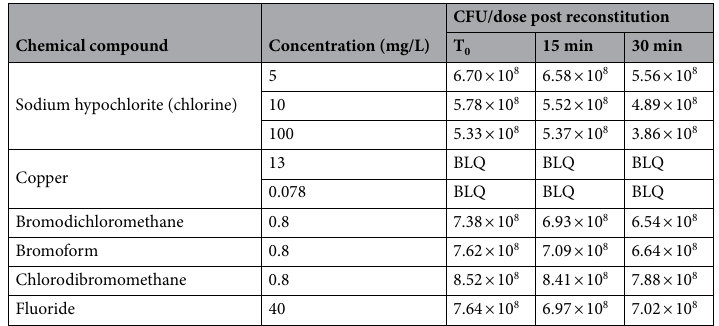
Table 4. Viability of CVD 103-HgR active component reconstituted in MBGW spiked with tap water chemical compound candidates (2019). Samples were run in singlicate for all CFU assays for water chemistry analysis.